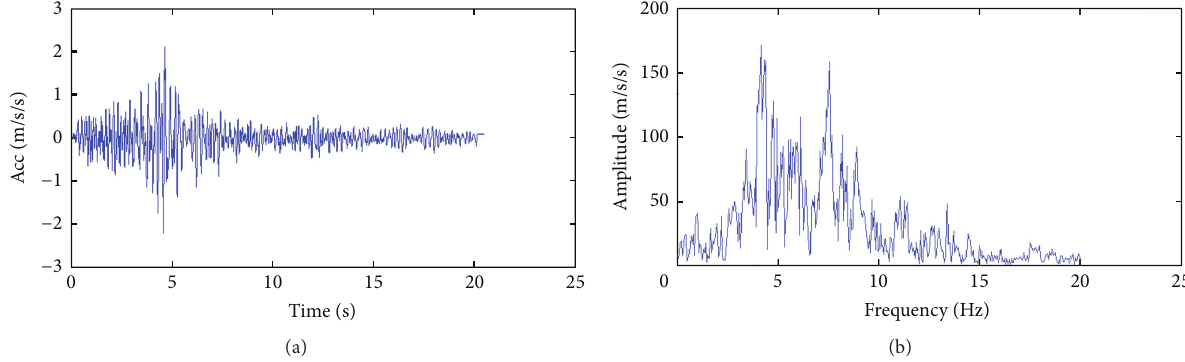
Figure 5: Time history and frequency spectrum of Minxian seismic wave loaded. (a) History time. (b) Fourier spectrum.